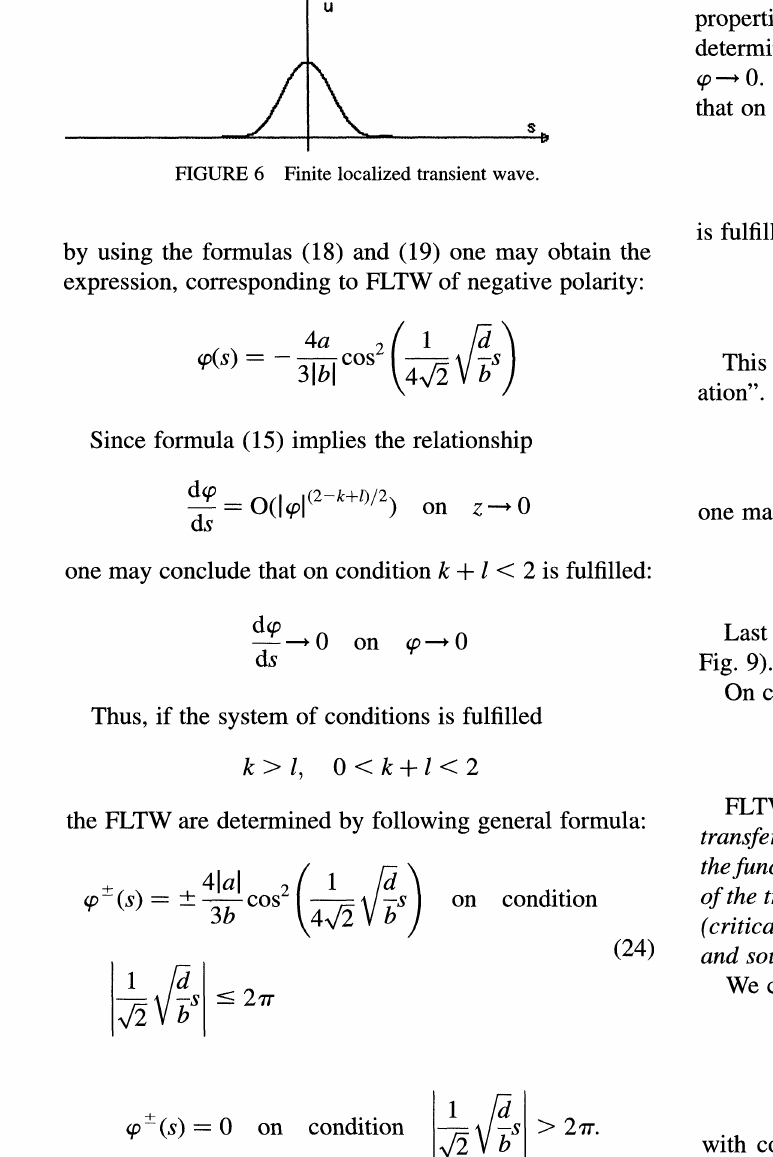
FIGURE 6 Finite localized transient